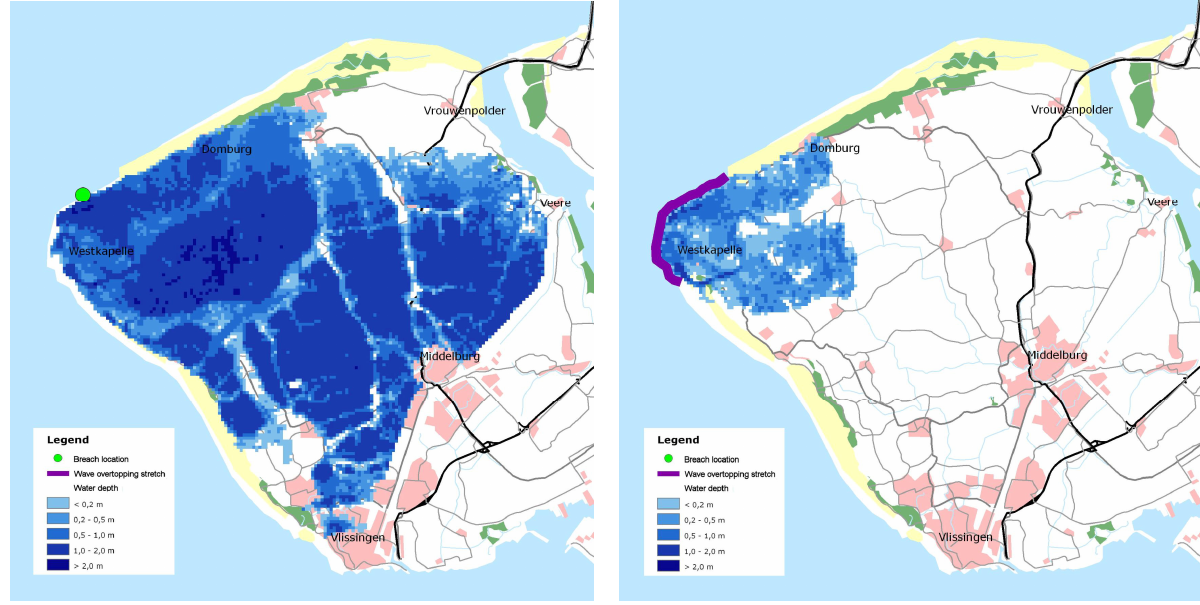
Fig. 2. Water depth resulting from a breach in conventional embankments (left), respectively from the overtopping of unbreachable embank- ments (right) as simulated for Walcheren (from Stijnen, 2008).